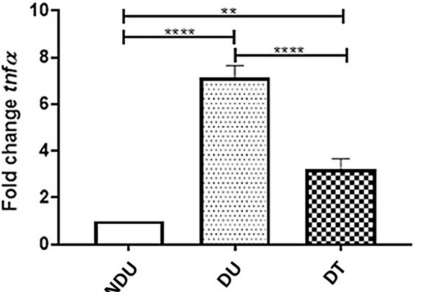
Figure 9. qRT-PCR analysis of DNS and NDS dystrophic and non-dystrophic larvae, untreated (0 mg L − 1 ) and treated (2, 4 and 8 mg L − 1 ) with 1,3-1,6 β -glucans. Three independent RNA samples from each group were evaluated: Non-dystrophic Untreated (NDU), Dystrophic Untreated (DU), Dystrophic Treated (DT). (** p ≤ 0,001, **** p ≤